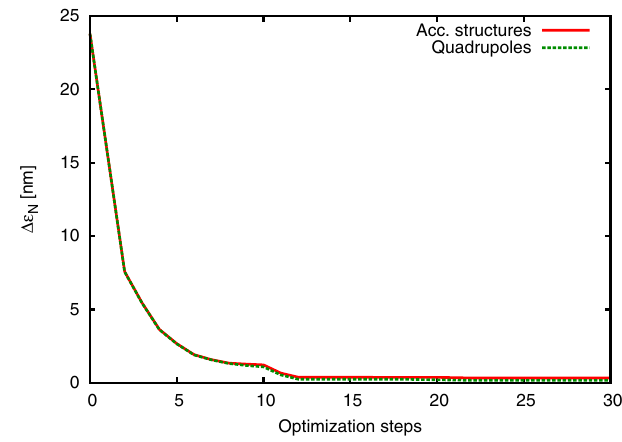
FIG. 22. Convergence of the tuning bumps based on quadru- pole displacements compared to the ones based on structure displacements. The performance is nearly